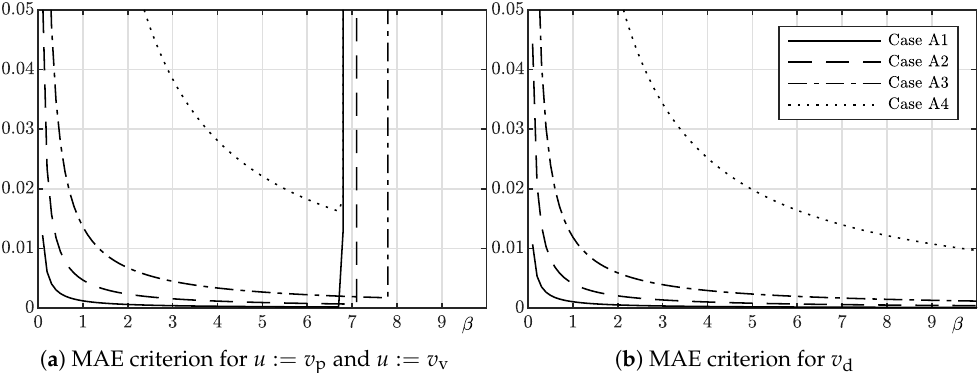
Figure 7. Values of MAE criterion obtained in simulations for gains values used in the